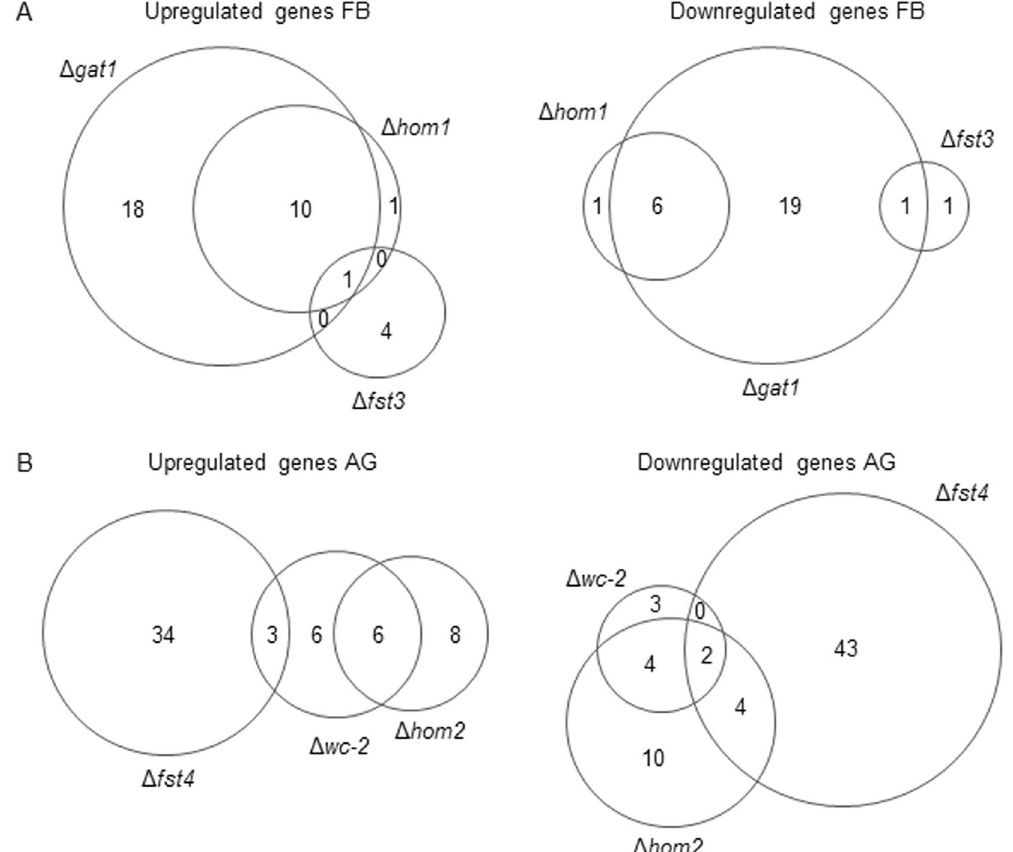
Figure 3. Venn diagrams showing overlapping differentially expressed transcription factor genes in Δ fst3 Δ fst3 Δ hom1 Δ hom1 and Δ gat1 Δ gat1 ( A ) and Δ wc-2 Δ wc-2 , Δ hom2 Δ hom2 , and Δ fst4 Δ fst4 ( B ) when compared to the wild-type aggregate and fruiting body stage,